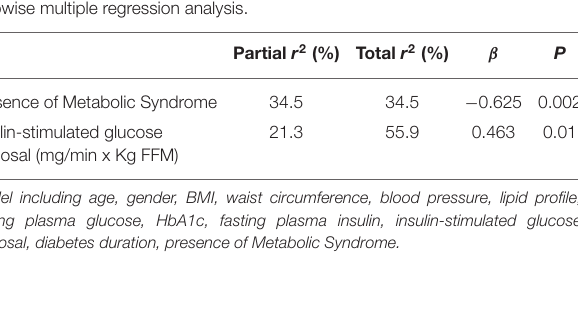
TABLE 3 | Independent predictors of myocardial glucose metabolism after stepwise multiple regression analysis.